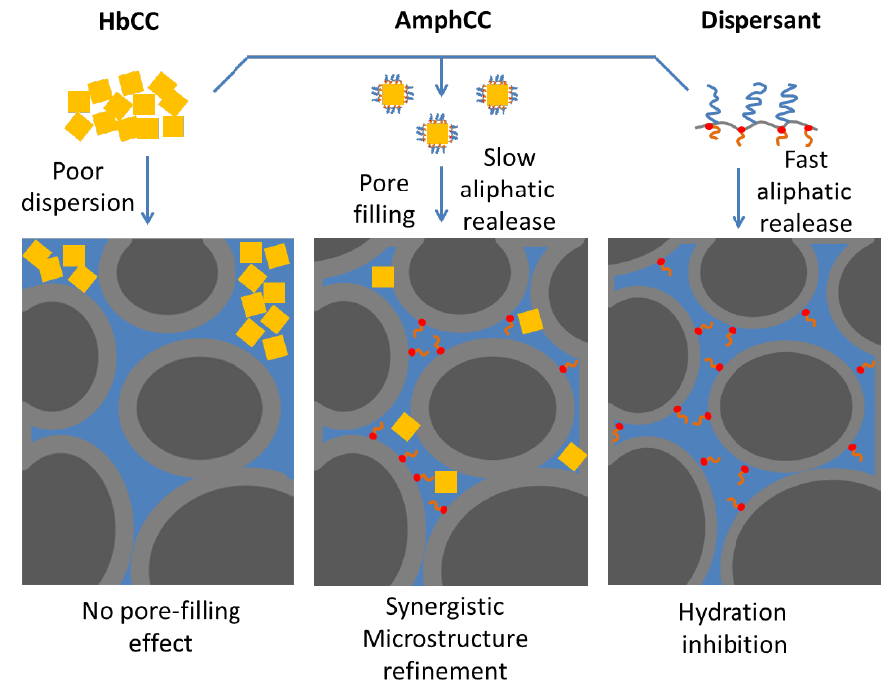
Figure 9. Mechanism illustration of the effect of AmphCC.